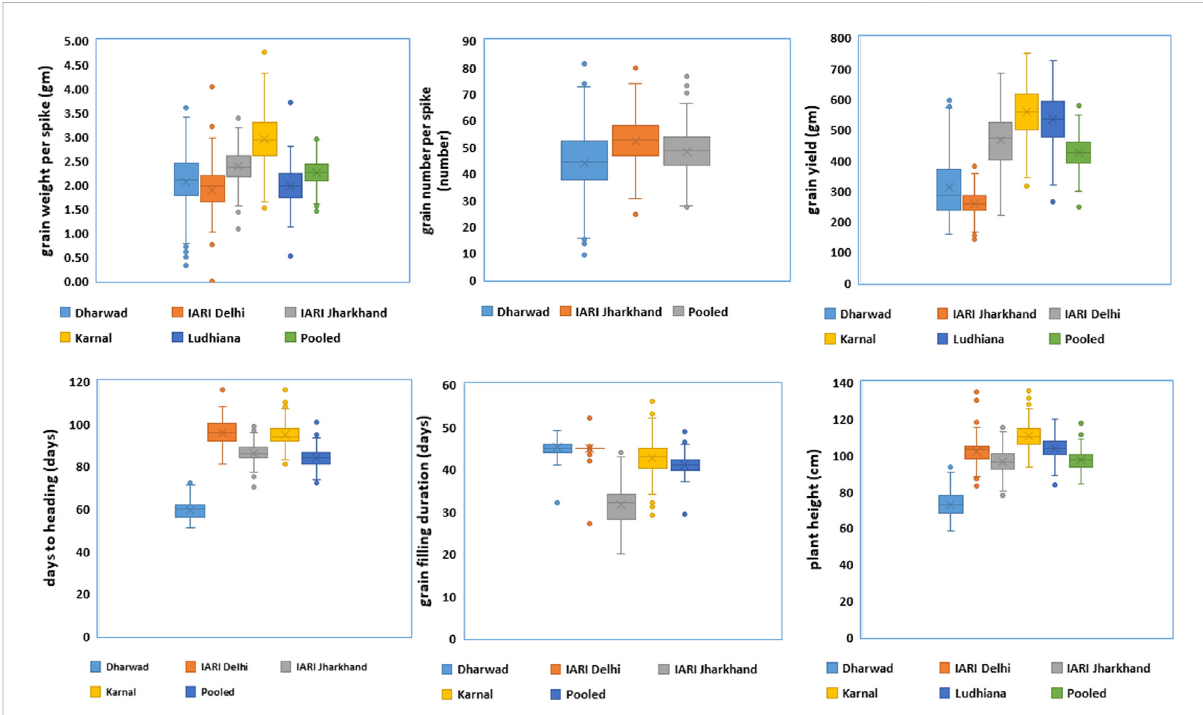
FIGURE 1 Boxplots of grain yield and component traits in GWAS panel evaluated at Dharwad, IARI Delhi, IARI Jharkhand, Karnal, and Ludhiana during 2020 –